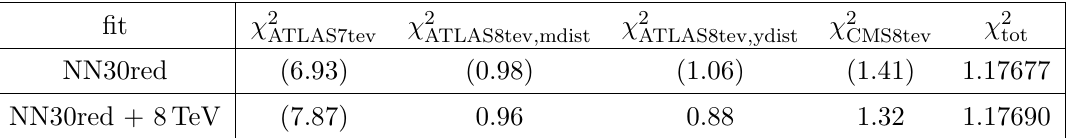
data is added to the global (cid:12)ts. T distributions. We have labeled our T